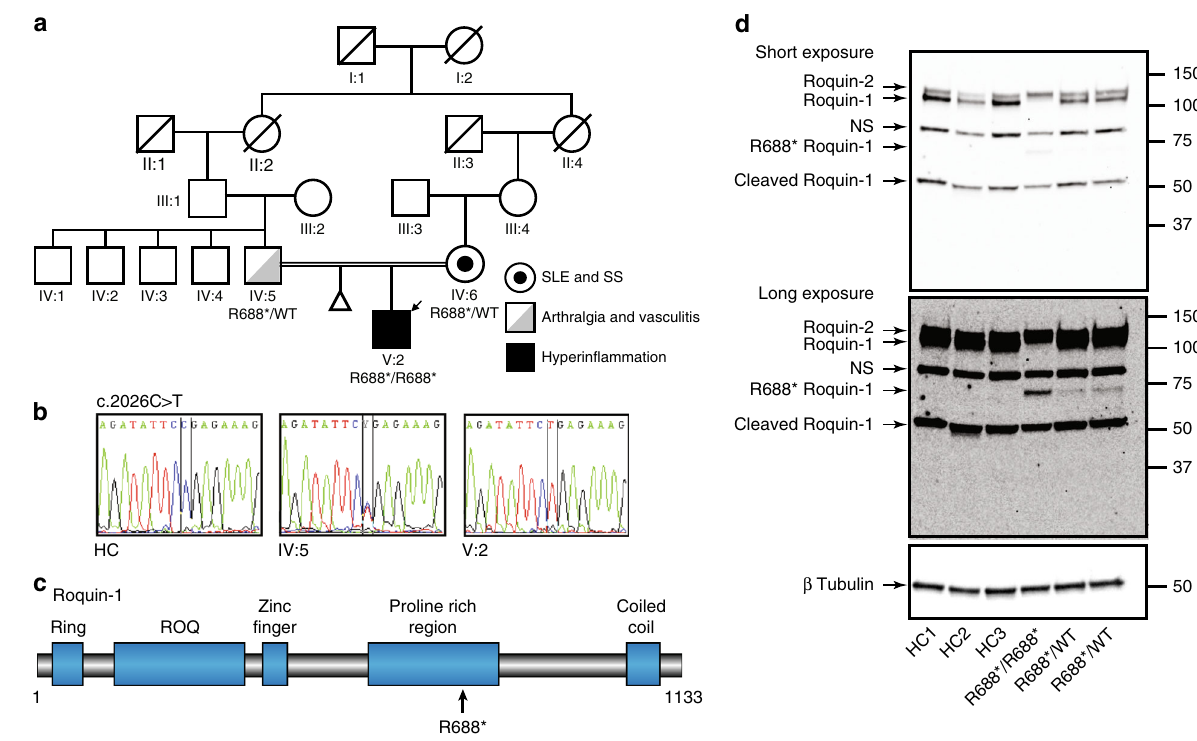
Fig. 1 Identi fi cation of a nonsense R688* mutation in RC3H1 in a consanguineous family. a Family pedigree indicating the index patient (V:2) with an arrow, the consanguineous link (double line) between the index patient ’ s parents and reported medical conditions as indicated in the legend. b Sanger sequencing of complementary DNA from selected individuals and control. c Graphical representation of Roquin-1 protein structure with indication of the R688* mutation. RING: Really Interesting New Gene zinc fi nger motif. ROQ: roquin-family RNA binding domain. Zinc fi nger: CCCH zinc fi nger motif. Coiled Coil: Coiled coil domain. d Immunoblot analysis of Roquin-1, its paralog Roquin-2, their cleavage products and the truncated R688* mutant in healthy controls (HC), the R688* proband and both parents. β -Tubulin is used as a loading control. NS: nonspeci fi c band, SLE: systemic lupus erythematosus, SS: Sjögren ’ s syndrome. Source data are provided as a Source Data fi